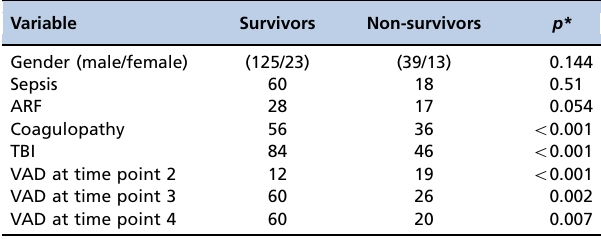
ARF – acute renal failure; TBI – traumatic brain injury; VAD – vasoactive drug use. *significance level p o 0.05.